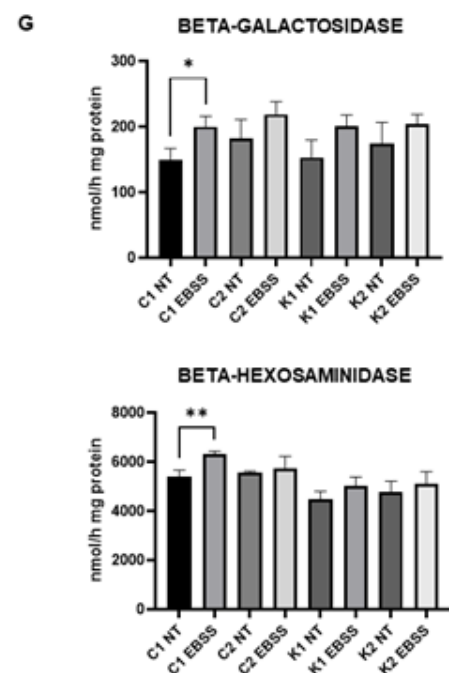
Figure 4. Representative images of fibroblasts stained with Lysotracker Red DND-99 after 4 h in EBSS, acquired using an Olympus BX-50 fluorescence microscope at ( A ) 40× objective and ( B ) 100× objective (oil immersion). ( C ) Mean cell fluorescence determined after 4 h in EBSS. Fluorescence was measured in all cells present in six different fields captured with 100× objective. Representative Western blot images of ( D ) cathepsin D ( E ) LAMP1, and ( F ) TFEB in growth conditions (NT) and after incubation in EBSS for 2 h and 4 h. ( G ) beta-galactosidase and beta-hexosaminidase activities measured in growth condition (NT) and after 4 h in EBSS. Data are the mean ± SD of independent experiments ( n = 3). Statistical significance was calculated by unpaired t-Student comparing activity recorded after culture in EBSS (EBSS) with that recorded in growth condition (NT) for each cell type. *: p < 0.05; **: p < 0.01. C1: Control 1 fibroblasts; C2: Control 2 fibroblasts; K1: Krabbe 1 fibroblasts; K2: Krabbe 2 fibroblasts. NT: non-treated.